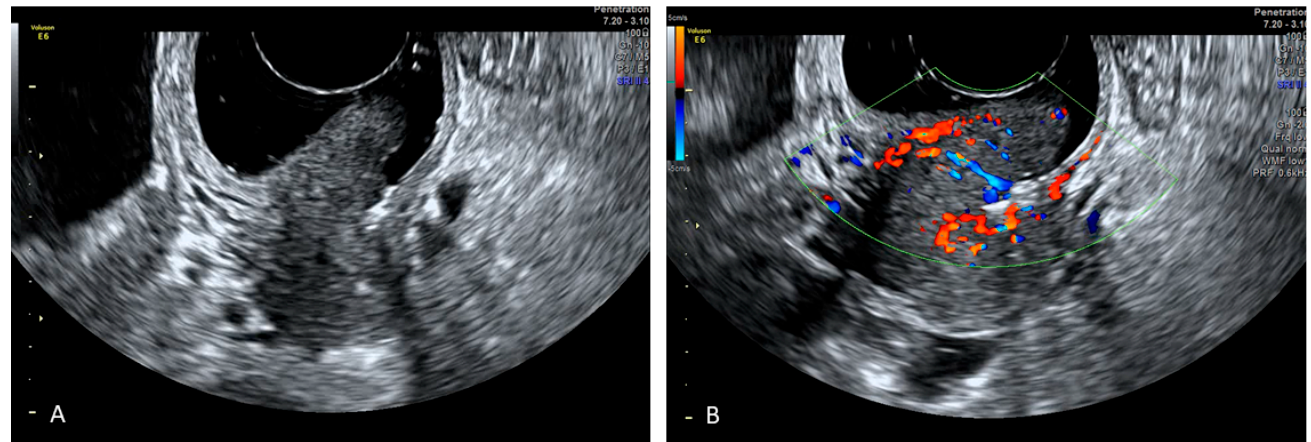
Figure 3. SVG image of an exophytic cervical cancer lesion (Panel ( A )) and its vascularization (Panel ( B )).